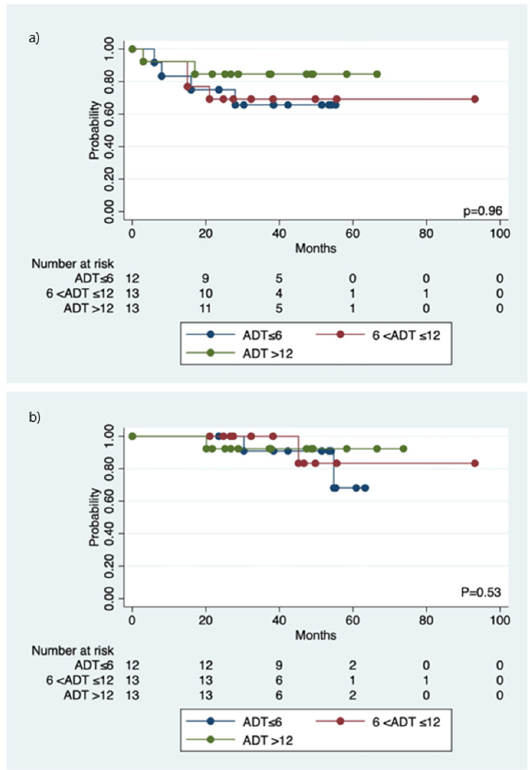
Figure 2. The cumulative 5-year biochemical-progression free survival ( a ) and overall survival ( b ) between the various ADT duration.